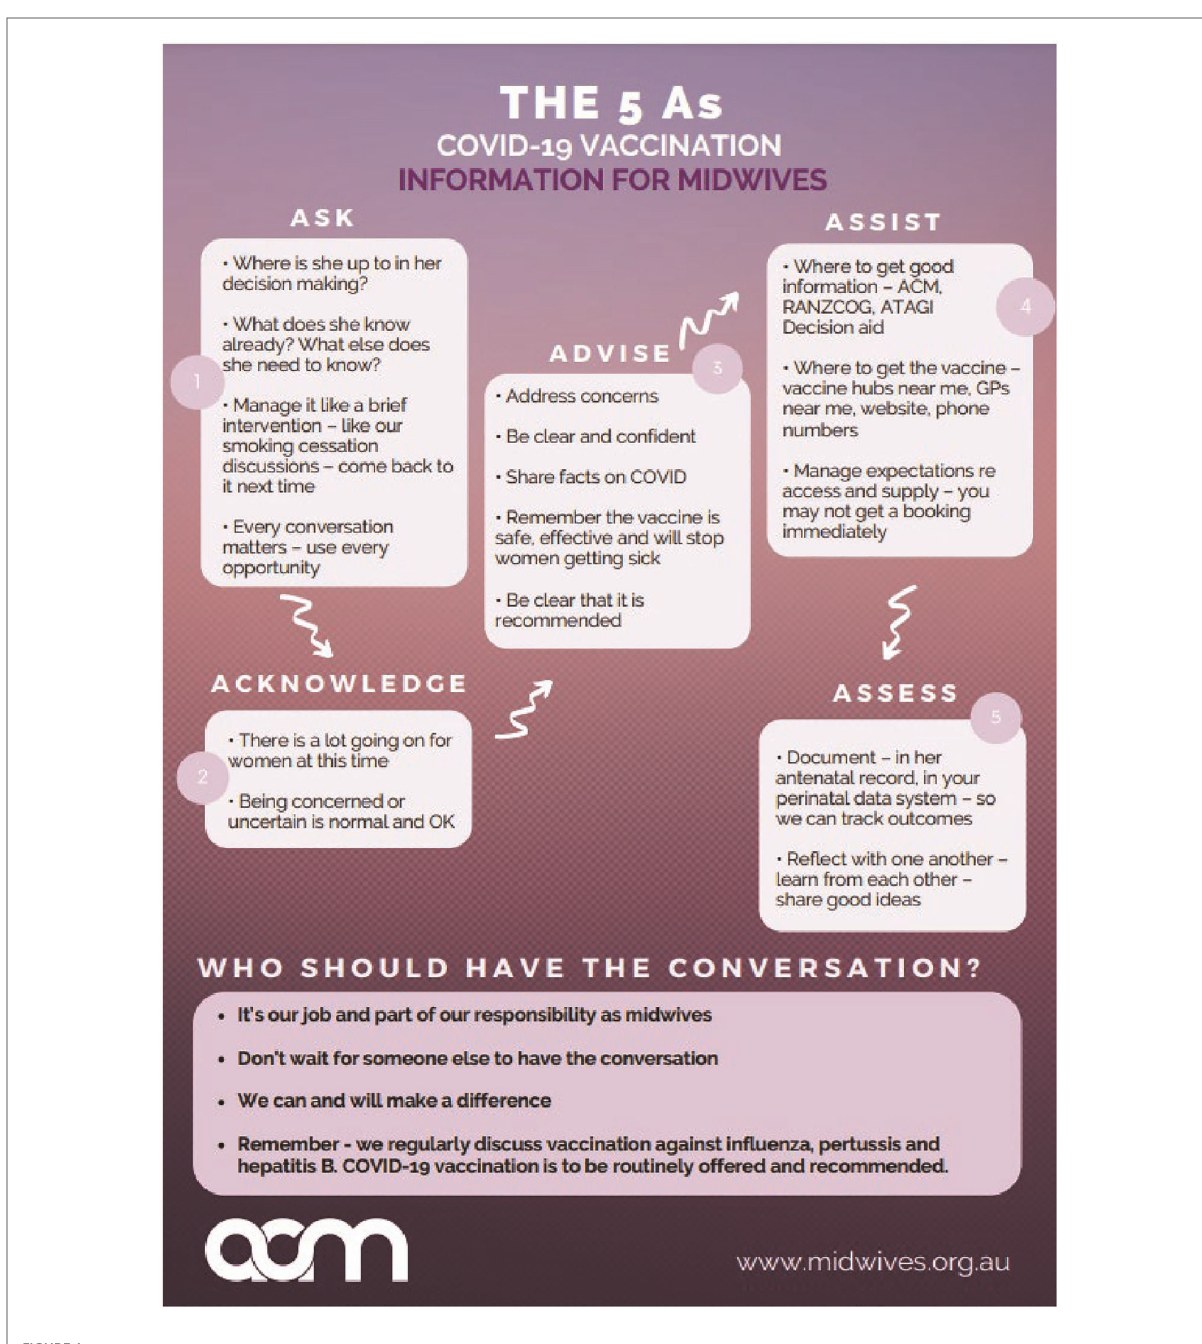
FIGURE 1 COVID-19 vaccination information for